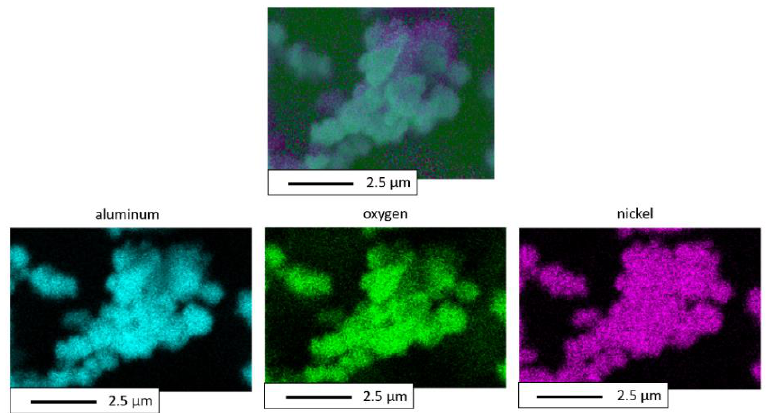
Figure 7. SEM micrographs of the NiAl + 30 wt.% Al 2 O 3 powder after mechanical alloying for 18 h.